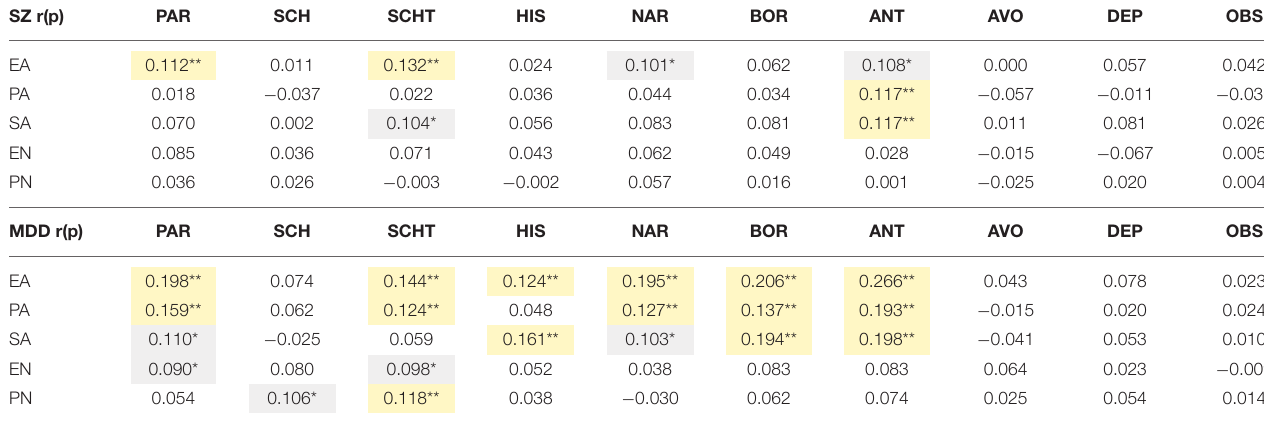
TABLE 4 | Correlations of different types of personality disorder traits in patients with schizophrenia and those with major depressive disorder. SZ r(p) PAR